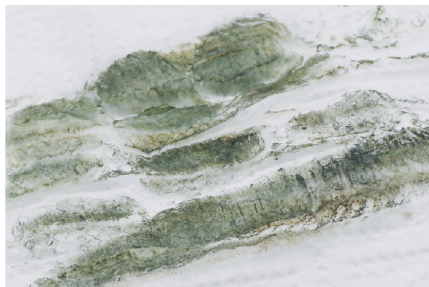
Figure 4: Corroded products on the surface of the sample.